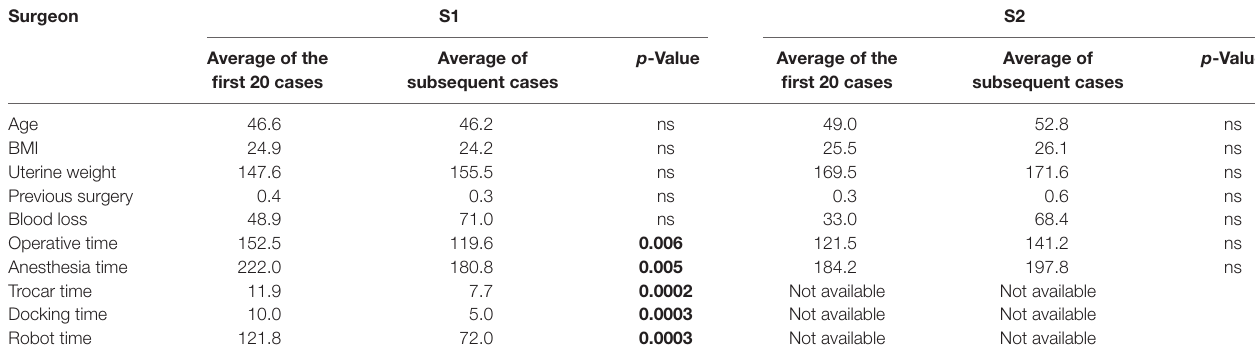
Bold font was chosen to highlight the statistical